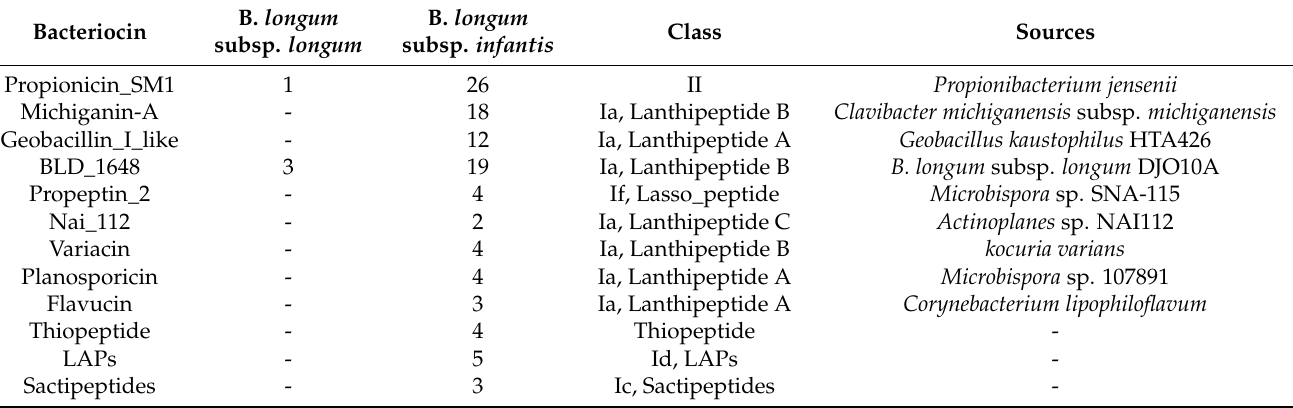
Figure 9. CRISPR spacers targeting prophages in B. longum . The vertical axis represented the genomes with prophages targeted by CRISPR spacers. The horizontal axis represents the B. longum CRISPR spacers targeting prophages. The heatmap indicates B. longum CRISPR spacers that match prophages in the B. longum genomes. The number of targeting is represented by colour ranging from yellow (absent) to red. The blue area represents B. longum subsp. longum and the red area represents B. longum subsp. infantis . Table 4. Class and sources of predicted bacteriocins in B. longum